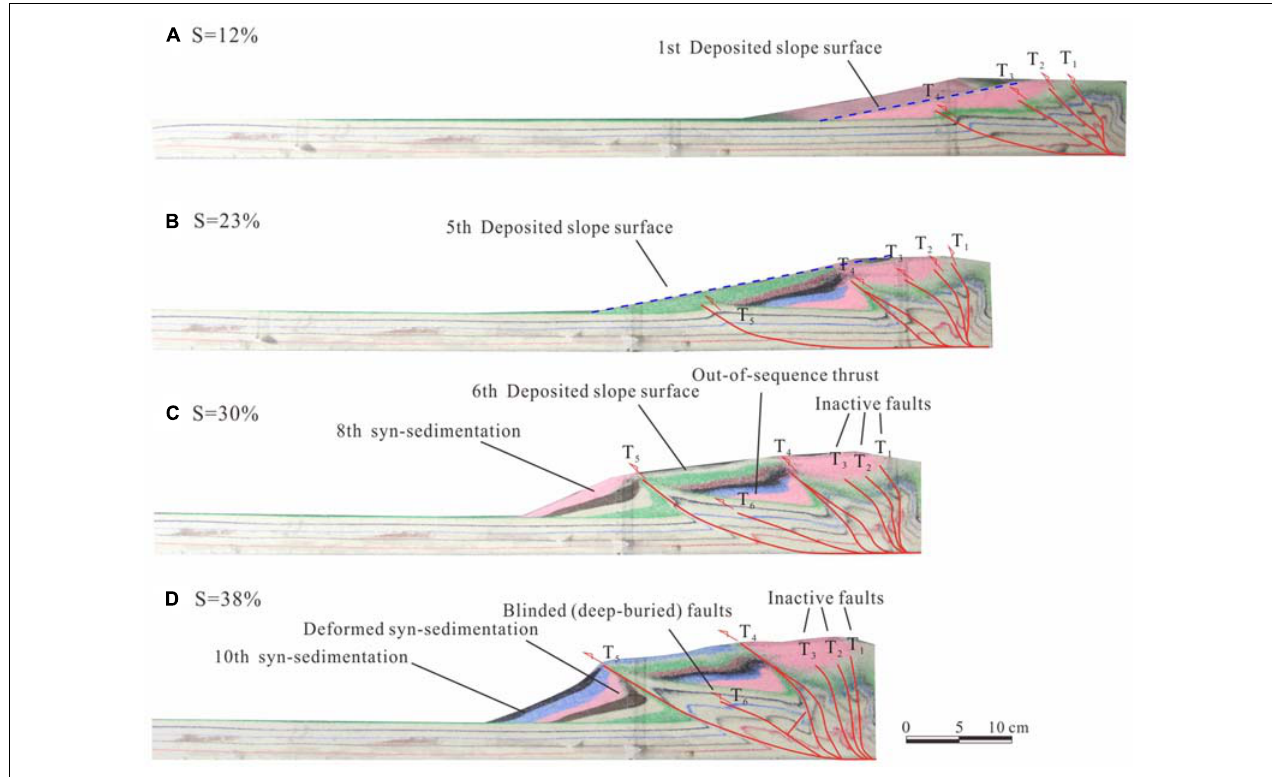
FIGURE 7 | Experiment results of medium-rate sedimentation model (S2). (A–D) Sequential photographs showing the structural evolution of